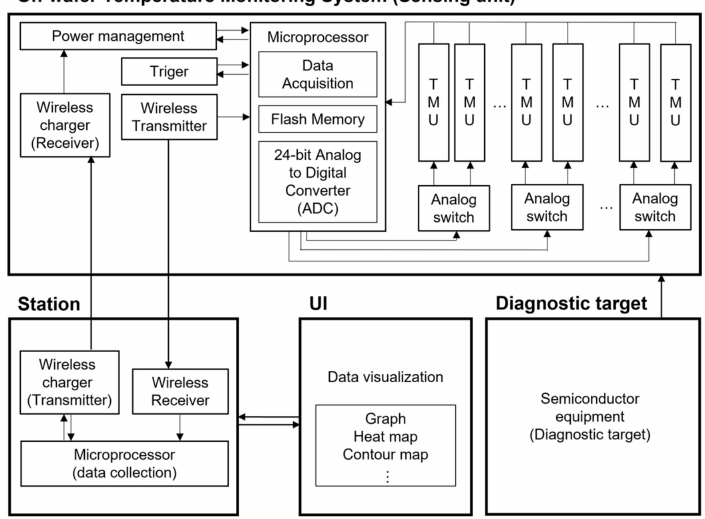
Figure 3. Block diagram of